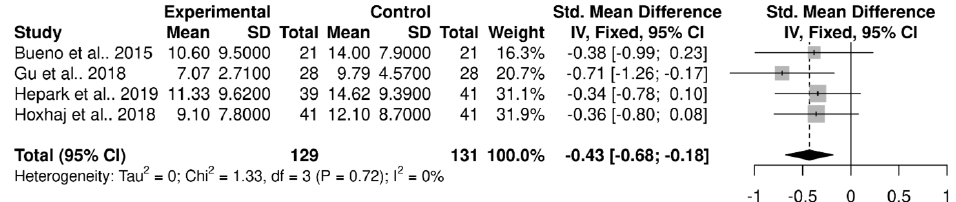
Figure 3. Random effects meta-analysis for Beck Depression Inventory (BDI) scores. Experimental refers to after the mindfulness intervention, whilst control provides baseline data [86,88,91,92].